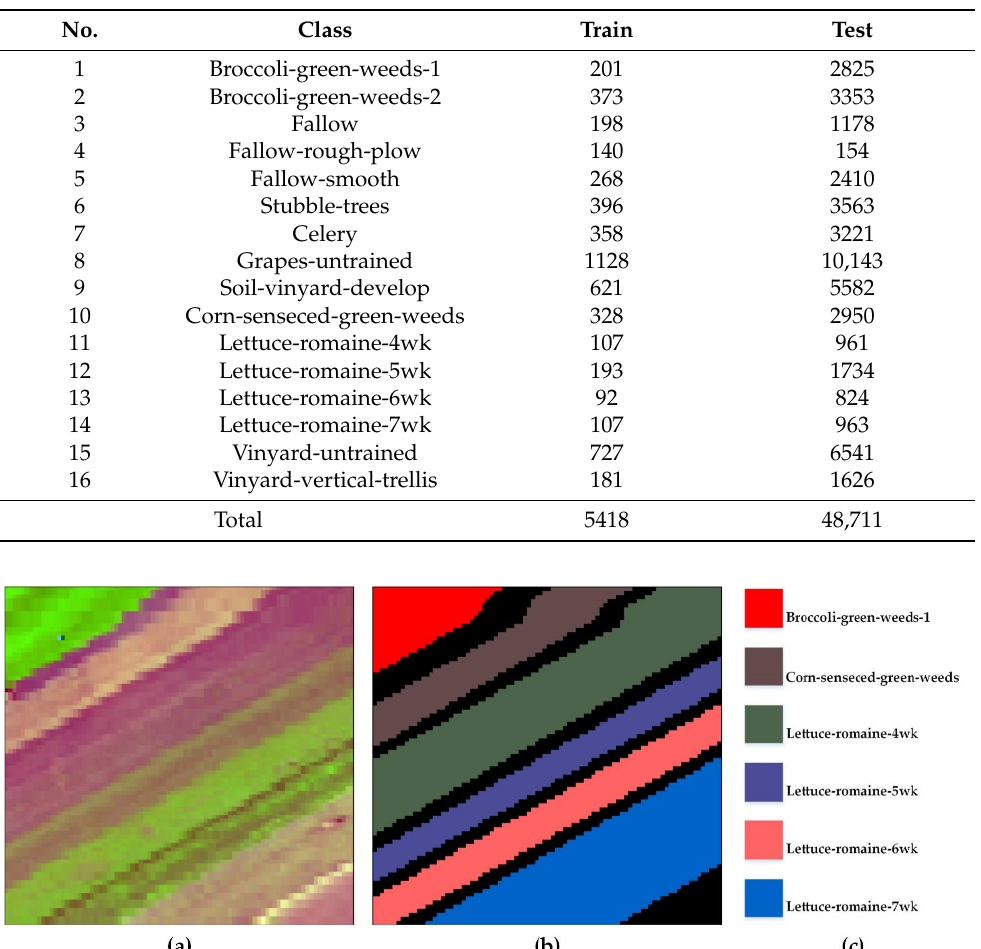
Figure 8. The IP dataset. ( a ) False-color image, ( b ) Ground-truth image, ( c ) Labels.